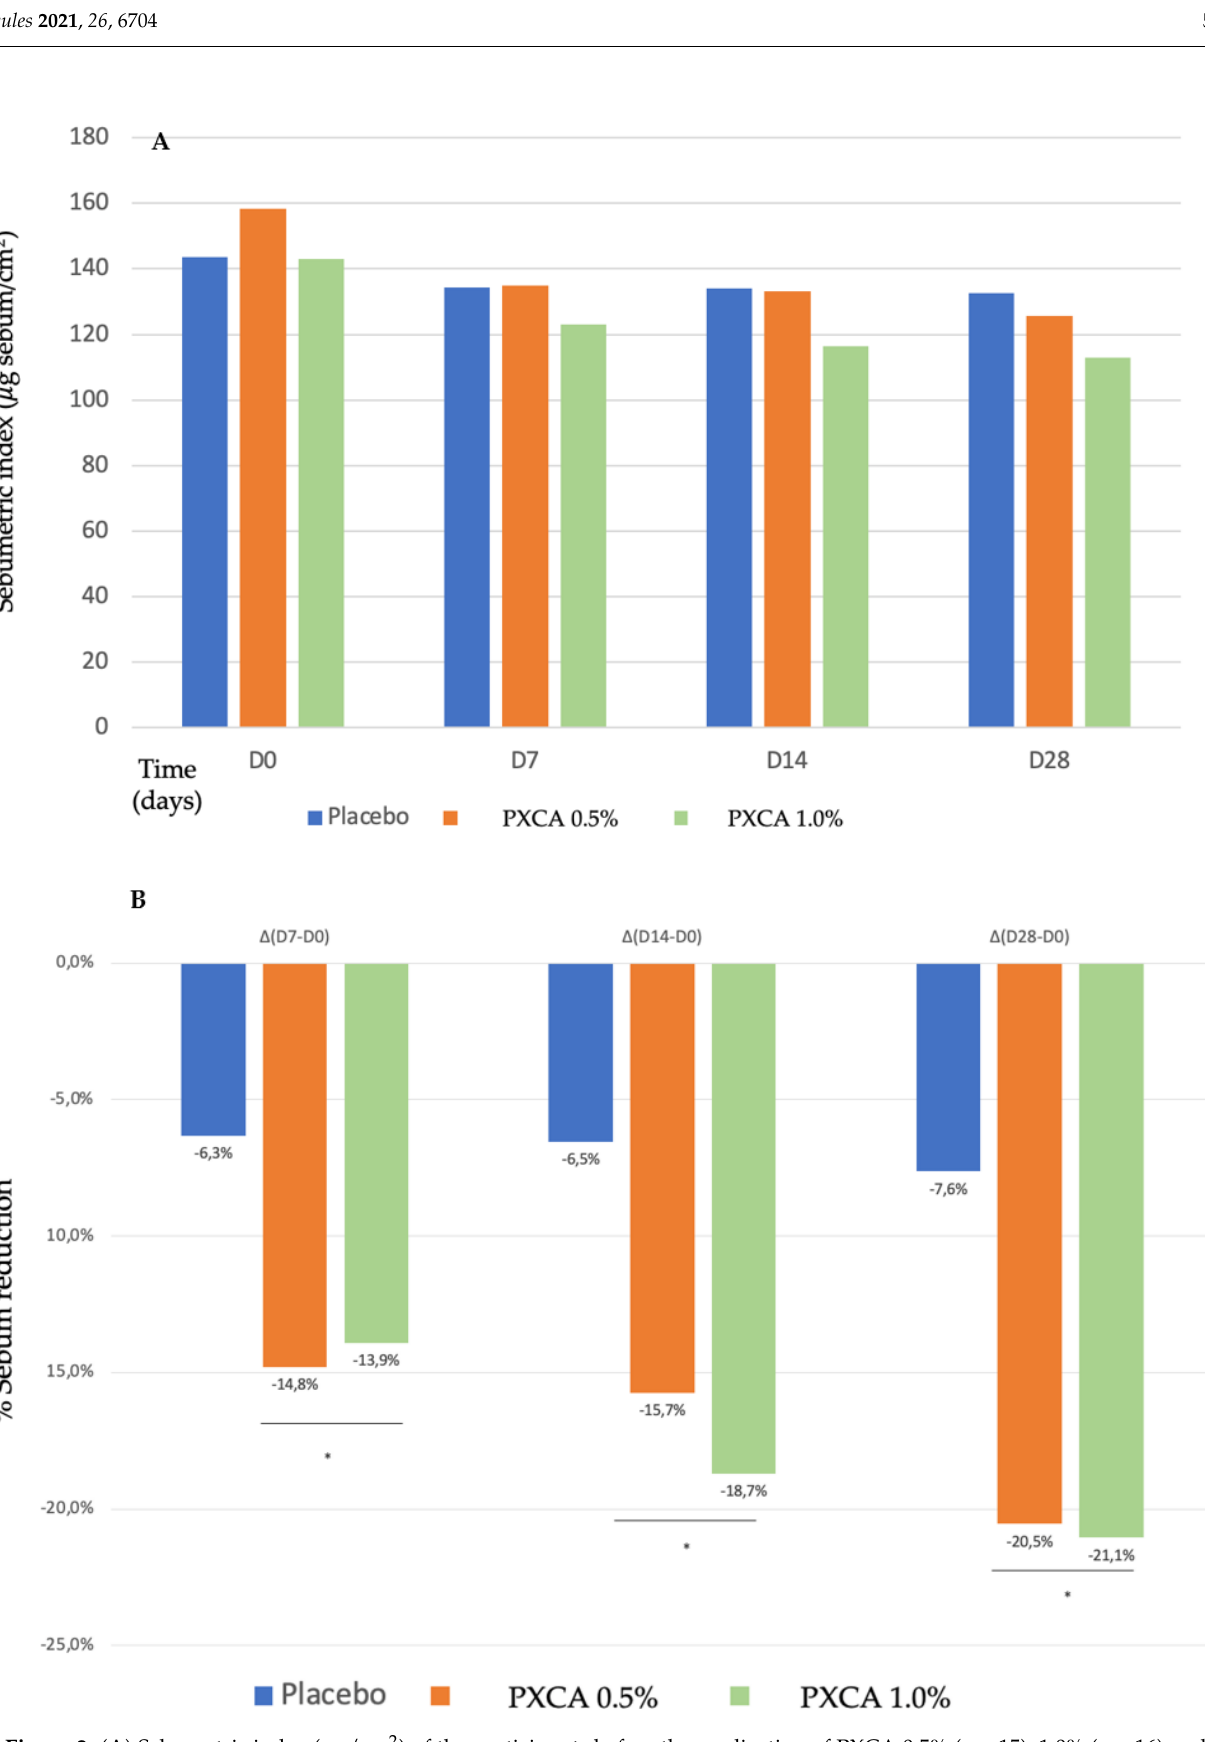
Figure 2. ( A ) Sebumetric index ( µ g/cm 2 ) of the participants before the application of PXCA 0.5% (n = 15), 1.0% (n = 16) and placebo (n = 13) (D0) and after 7 (D7), 14 (D14) and 28 (D28) days of use. ( B ) Sebum reduction variation (%) for PXCA 0.5% (n = 15), 1.0% (n = 16) and placebo (n = 13) per period (D7-D0/D14-D0/D28-D0). * p < 0.05 in relation to the initial time